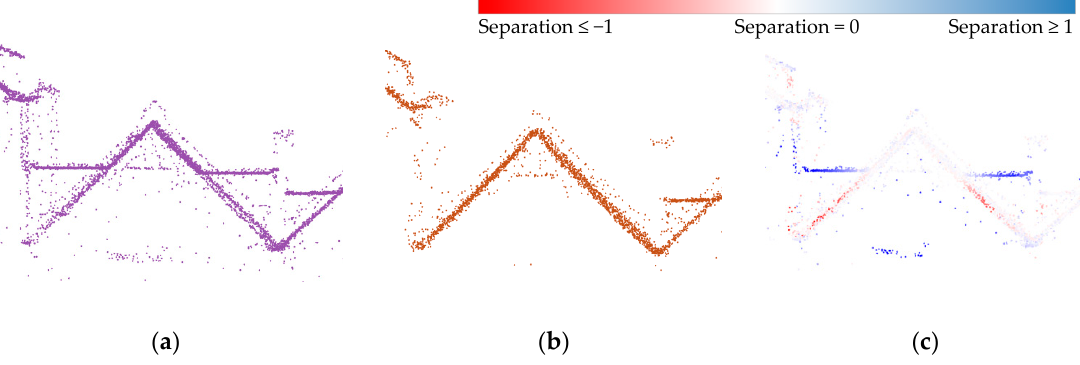
Figure 3. ( a , b ) Different colors represent different epochs of data, ( a ) 2012, ( b ) 2010; ( c ) Surface difference map—both epochs merged. The points in the rectangle have a distance difference ≤ 0.08 m, although there is indeed a change. The difference value is small because the points on the roof from the other epoch are in the neighborhood of the points on the dormer and they are quite close to each other. The problem is to identify the areas in the rectangle as being changed when the difference value is low.